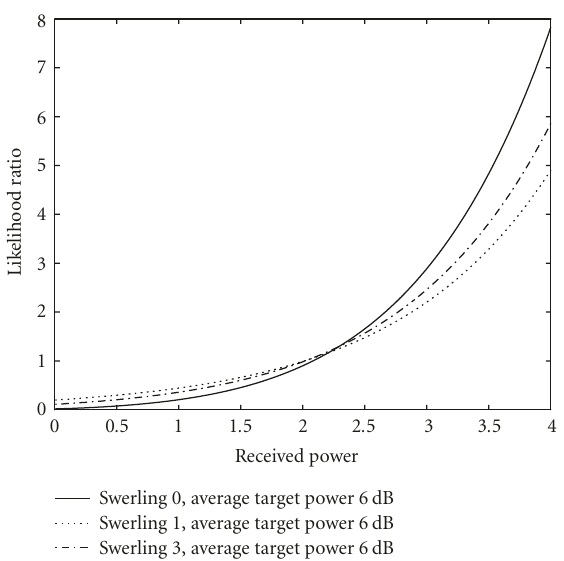
Figure 8: Variation of calculated likelihood ratios against received measurement power for postulated average target power 6dB above clutter